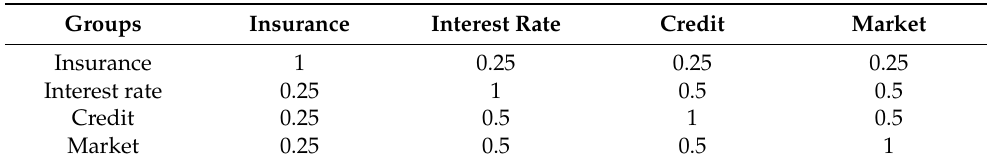
Table A2. Risk Coefficient for RBC